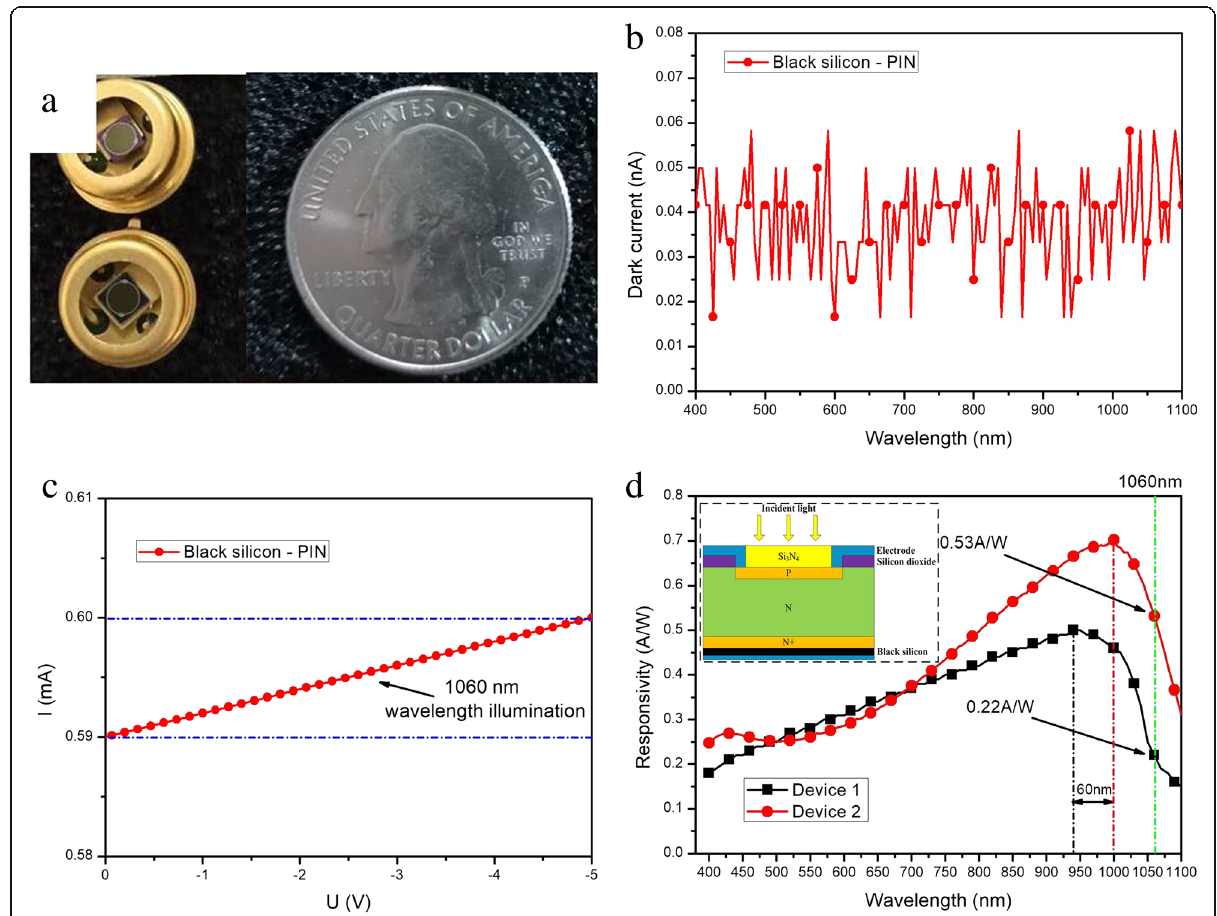
Fig. 8 Detector image ( a ), dark current ( b ), I – V curve under 1060 nm wavelength illumination ( c ), and responsivities of two different detectors ( d ): device 1 from ref. [22] and device 2 based on the results of present paper. The inset of d shows the device